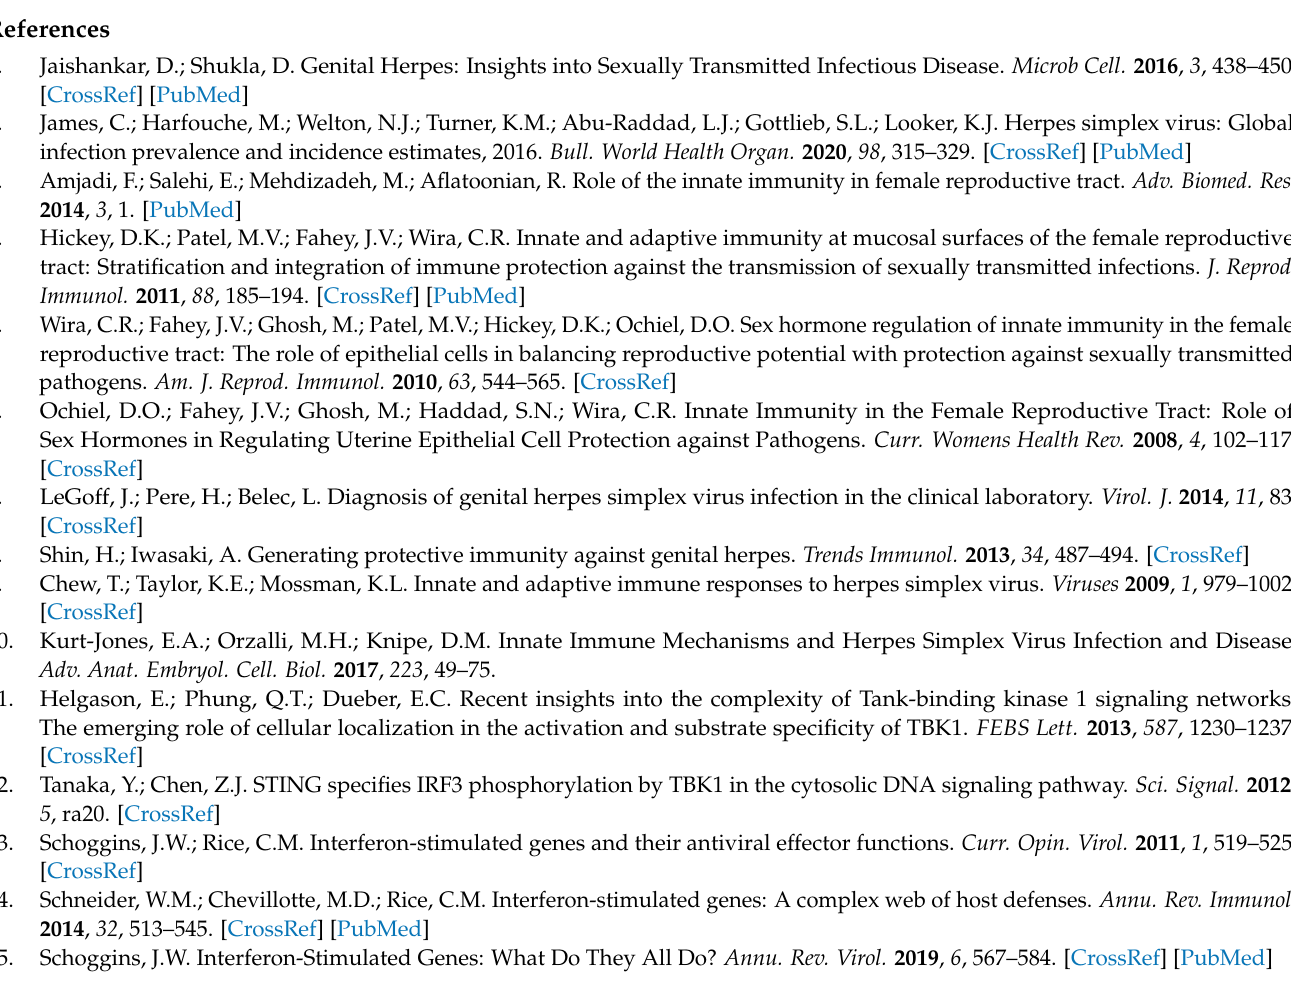
KO, Figure S2: IRF3 is activated at early hours of infection, Figure S3: HSV-2 infection